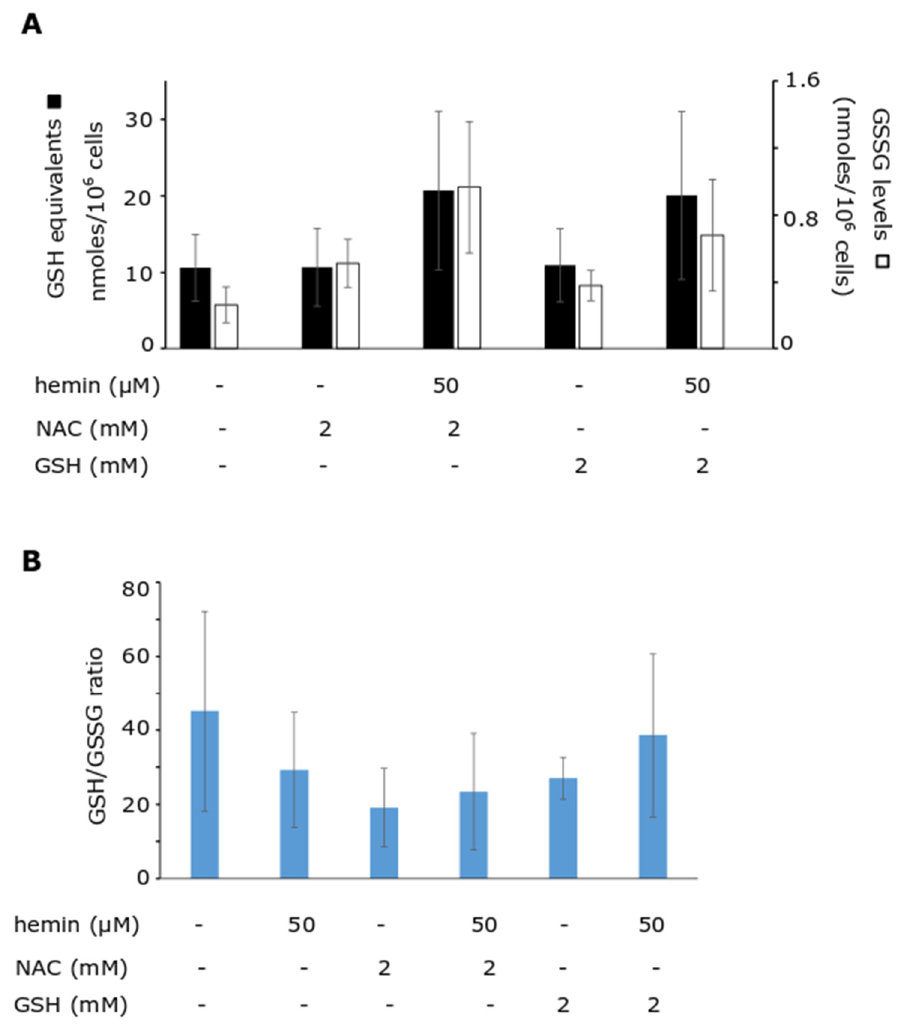
Figure 2. GSH equivalents, GSSG levels, and GSH/GSSG ratio in K562 cells treated